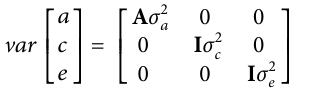
comparison between pedigree and genomic prediction